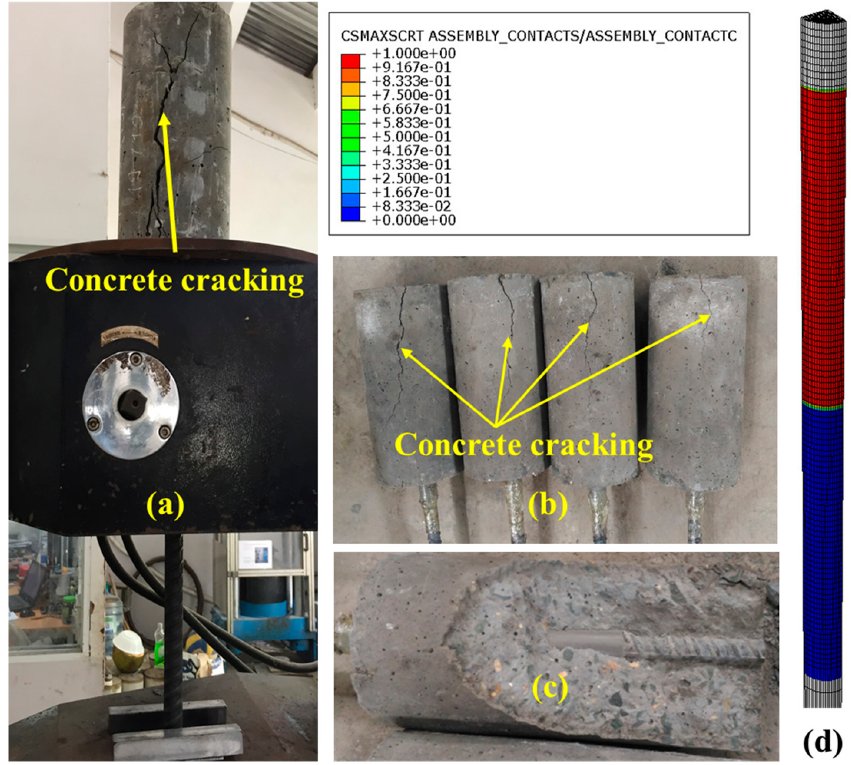
Figure 13. Failure mode of specimens: ( a ) splitting failure of concrete; ( b ) concrete cracking; ( c ) inside failure specimens; ( d ) damage initiation criteria in ABAQUS (a value of one indicates that the bond fails).